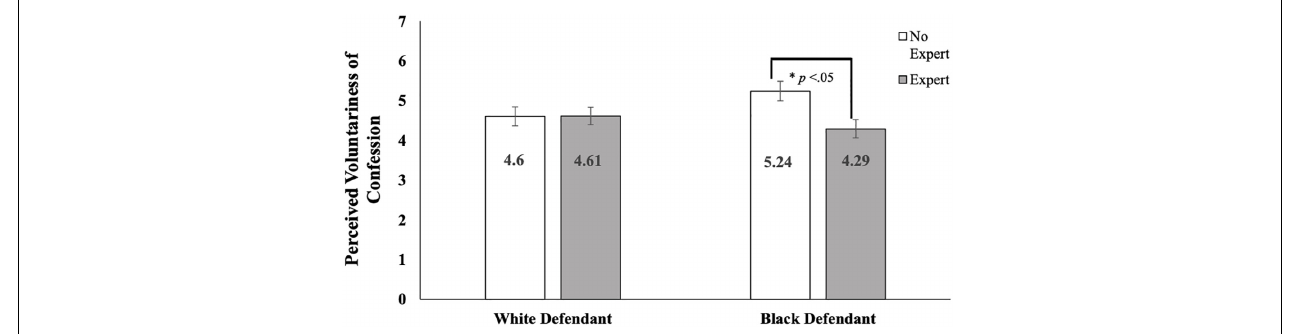
FIGURE 1 | Ratings of voluntariness of confession by defendant race and expert testimony for White participants.